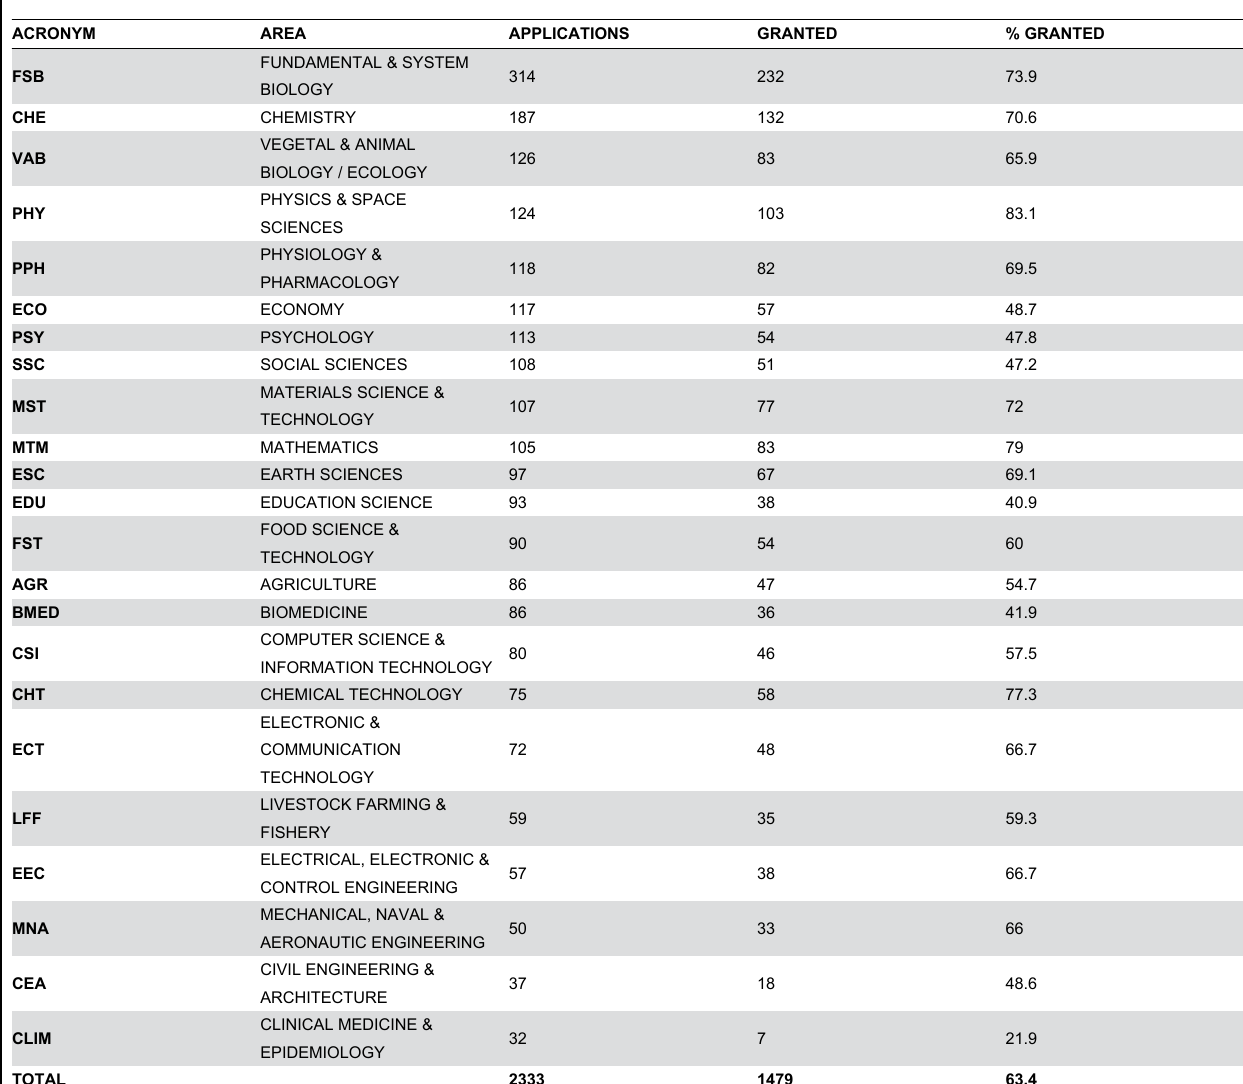
Table 1. Areas, total applications and applications granted per